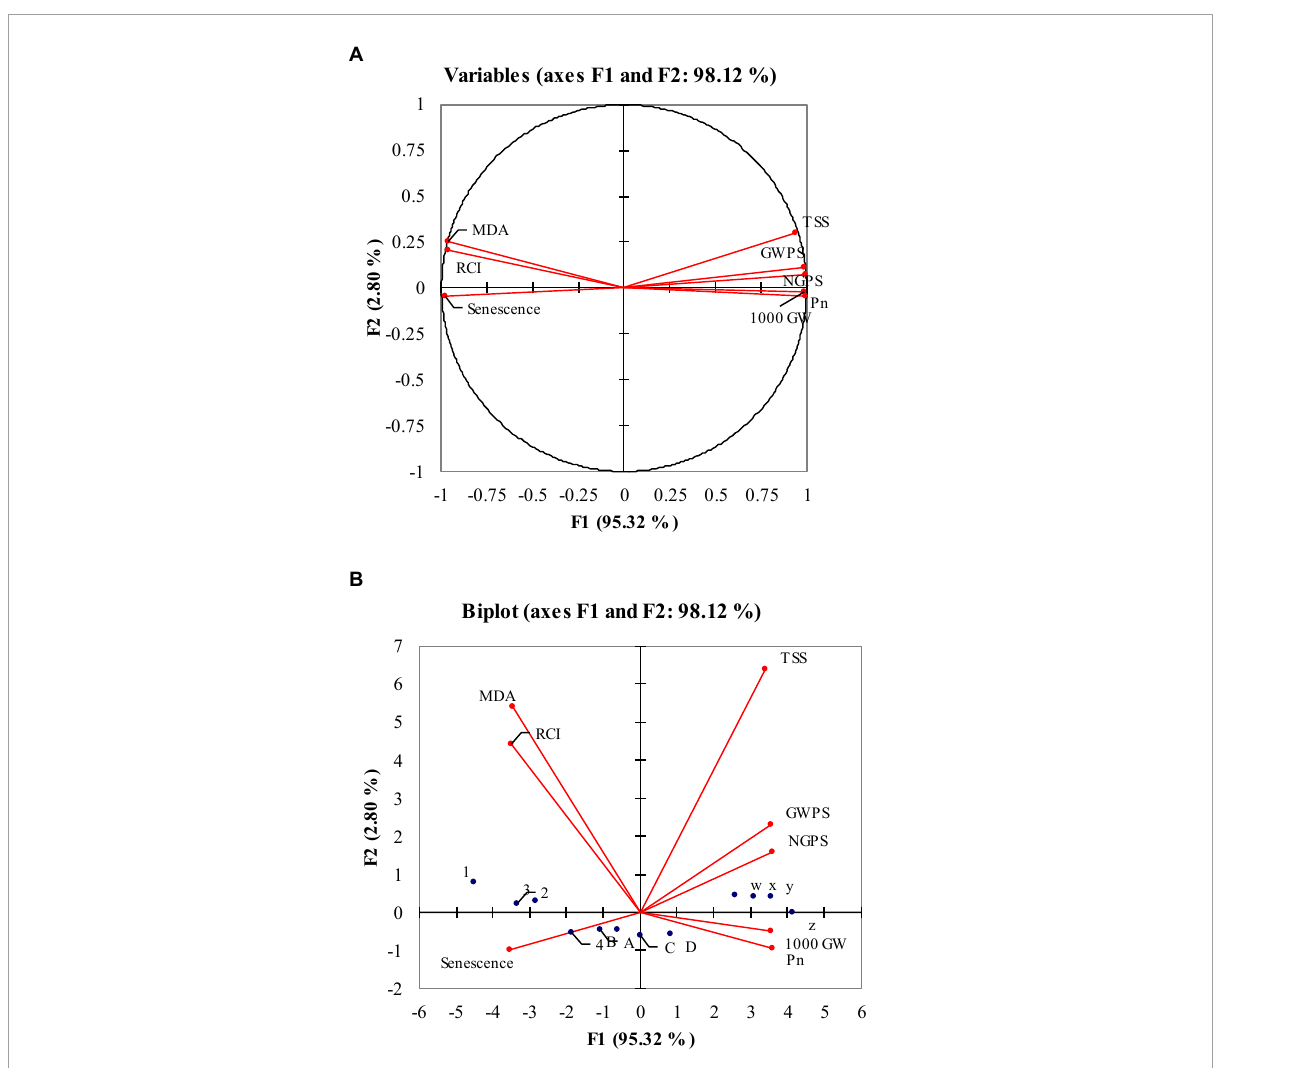
FIGURE4 Principle component analysis (PCA) (A,B) : monoplot and biplot correlation of malondialdehyde (MDA) relative cell injury (RCI), net photosynthetic rate (Pn), flag leaf senescence, 1,000 grain weight (1,000 GW), grain weight per spike (GWPS) and number of grains per spike (NGPS) under optimal, 4 and 8 days of heat stress 1 week after anthesis of polythene sheet (averaged across both years of study).